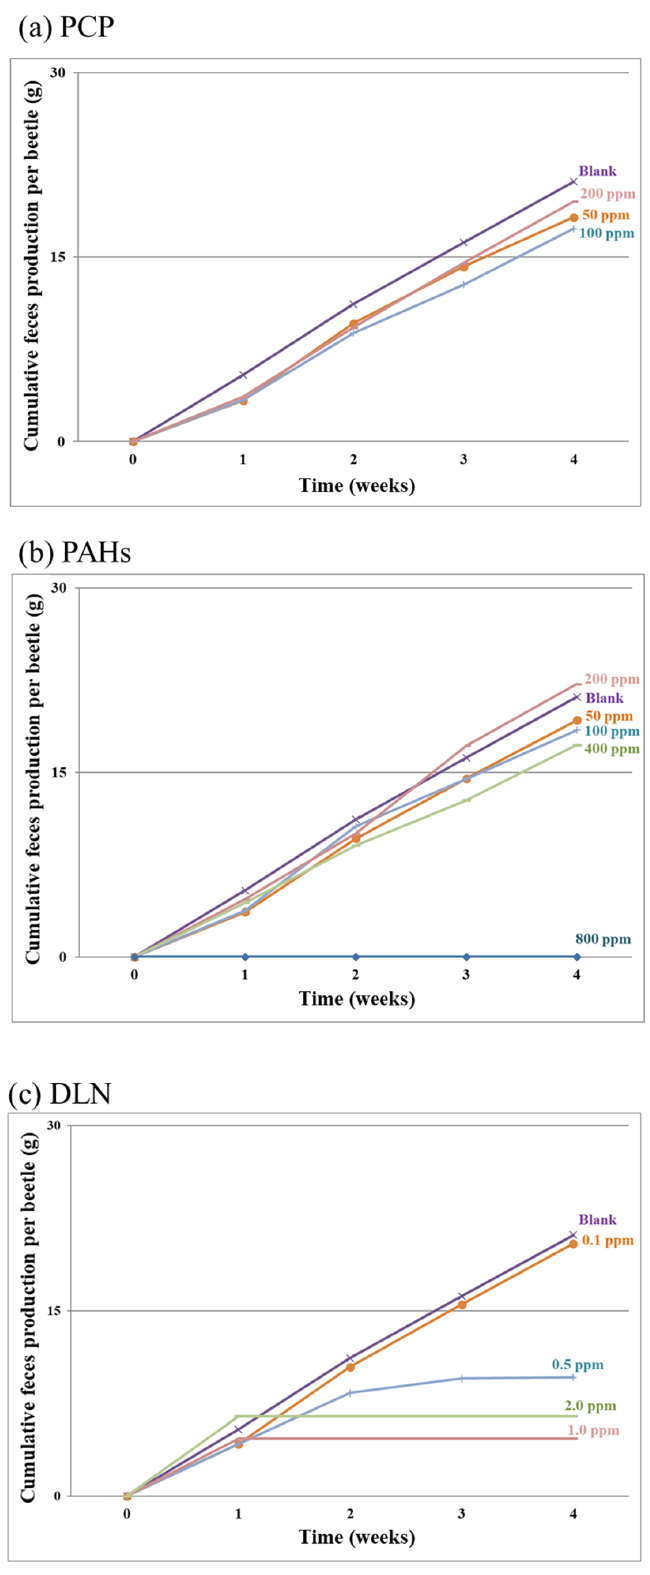
Figure 3. Cumulative feces production in the presence of the tested PCP, PAHs and DLN, as labeled in ( a – c ), respectively.